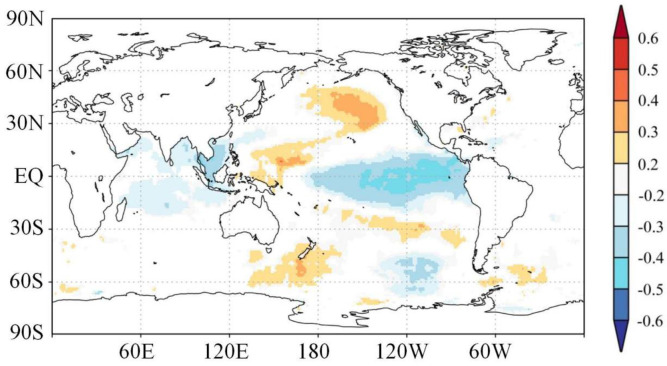
Correlations between the reconstructed EASM and precedent winter (from December to February) global SSTs for the period of 1871–2014.Correlations not significant at the 95% level have been masked out. The maps were produced with GrADS v2.2.0 software (http://cola.gmu.edu/grads/) in KNMI Climate Explorer.